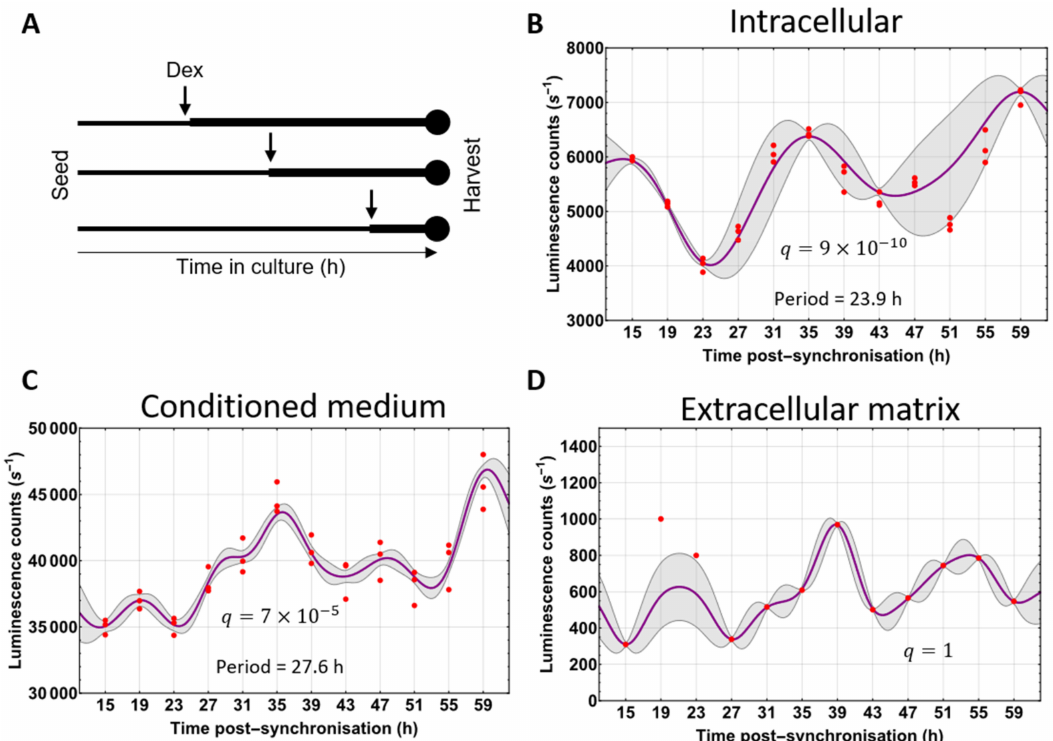
Figure 4. Circadian fluctuations in cellular NLuc-PC-I. ( A ) Schematic of experiments performed to assess circadian fluctuations in PC-I in nluc::Col1a2 cells whilst maintaining consistent cell numbers. ( B ) The levels of cellular NLuc-PC-I activity over 48 h, MetaCycle analysis indicated a 23.9 h periodic fluctuation in cellular procollagen. Graph shows n = 3 independent replicate data points (red), Gaussian process predicted function (purple), and standard deviation of the Gaussian process (grey). ( C ) The levels of secreted NLuc-PC-I activity over 48 h. MetaCycle analysis indicated a 27.8 h periodic fluctuation in secreted NLuc-PC-I. The cellular and secreted NLuc-PC-I levels follow the same pattern. Graph shows n = 3 independent replicates. ( D ) The incorporation of NLuc-collagen-I into the extracellular matrix was assessed following decellularisation at each time. Whilst levels fluctuated over 48 h, MetaCycle analysis did not indicate a periodic incorporation of NLuc-collagen-I into the extracellular matrix. Graph shows n = 3 independent